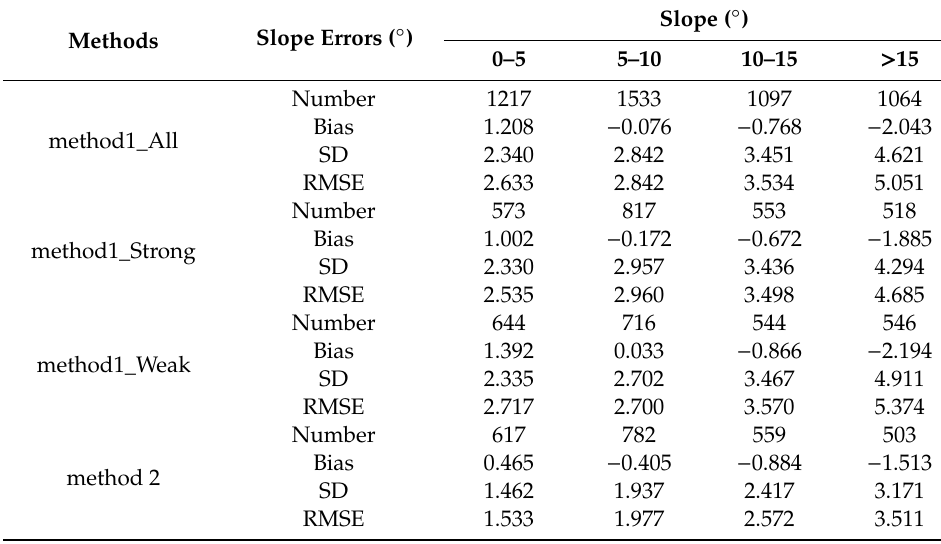
Table 5. Statistical errors of di ff erent methods, classified by